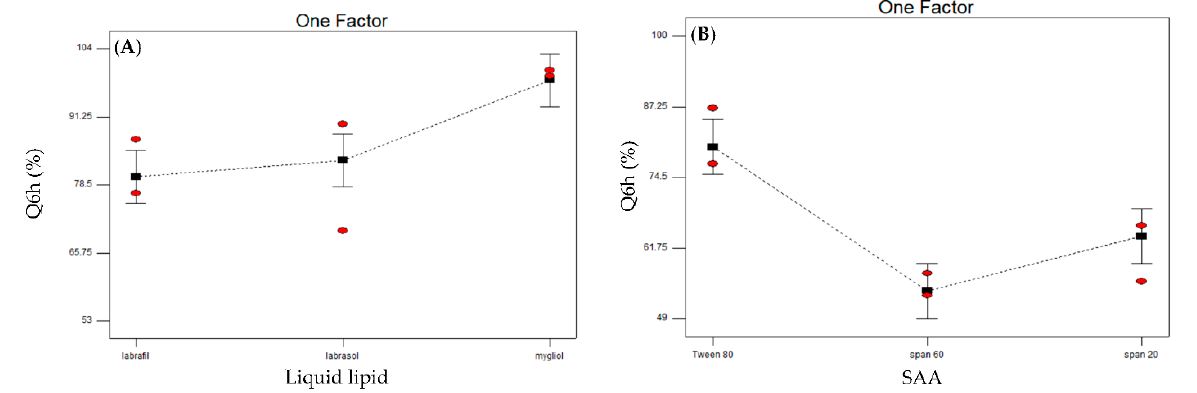
Figure 3. In vitro ZMP release profiles from the prepared NLCs ( A ) and drug solution in PBS (pH 7.4) at 35 ± 0.5 ◦ C ( B ), mean ± SD, n = 3.